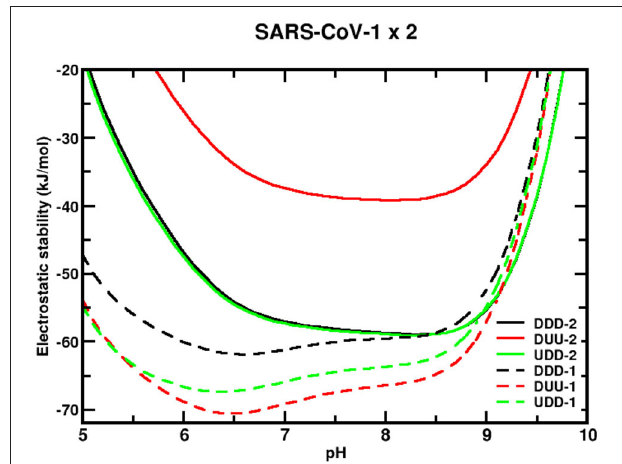
FIGURE 5 | Simulated electrostatic stability profiles for the sequences of SARS-CoV-1 and SARS-CoV-2 wt spike homotrimers as a function of pH. The chains are in three different conformational states: DDD, DUU, and UDD, which are represented in black, red, and green, respectively. The continuous lines refer to SARS-CoV-1, and the dashed lines refer to SARS-CoV-2 wt. The three-dimensional coordinates of the used structures in these CpH MC simulations were obtained from MD trajectories described in the text. Each curve in this plot is an average of over 10 CpH simulations carried out with a trimer coordinate extracted from a different MD replica. Salt concentration was fixed at